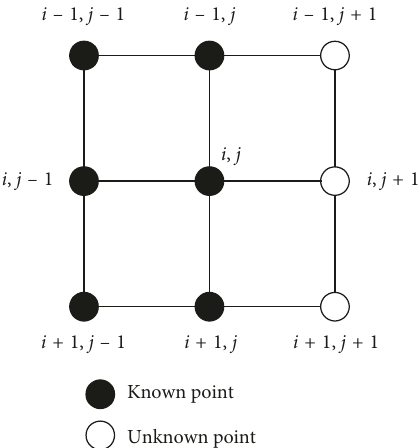
Figure 6: Three-storey implicit difference format.